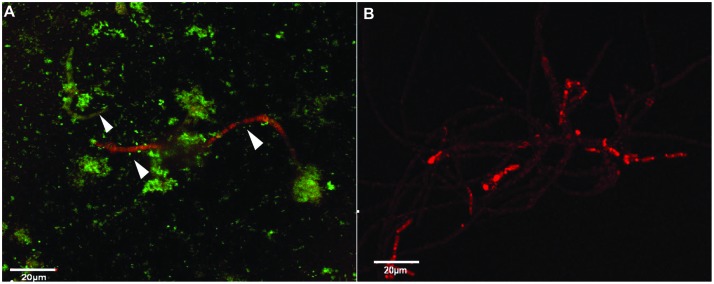
The effect of gentamicin on P. aeruginosa (PASS01) and S. aurantiacum (WM 06.482) co-cultures growing in SCFM at 37°C for 24 h. Scale = 20 μm. (A) Co-culture of WM 06.482 and PASS01 without the antibiotic. (B) Active growth of S. aurantiacum in a co-culture treated with 8 mg/ml of gentamicin to eradicate the bacterial growth.